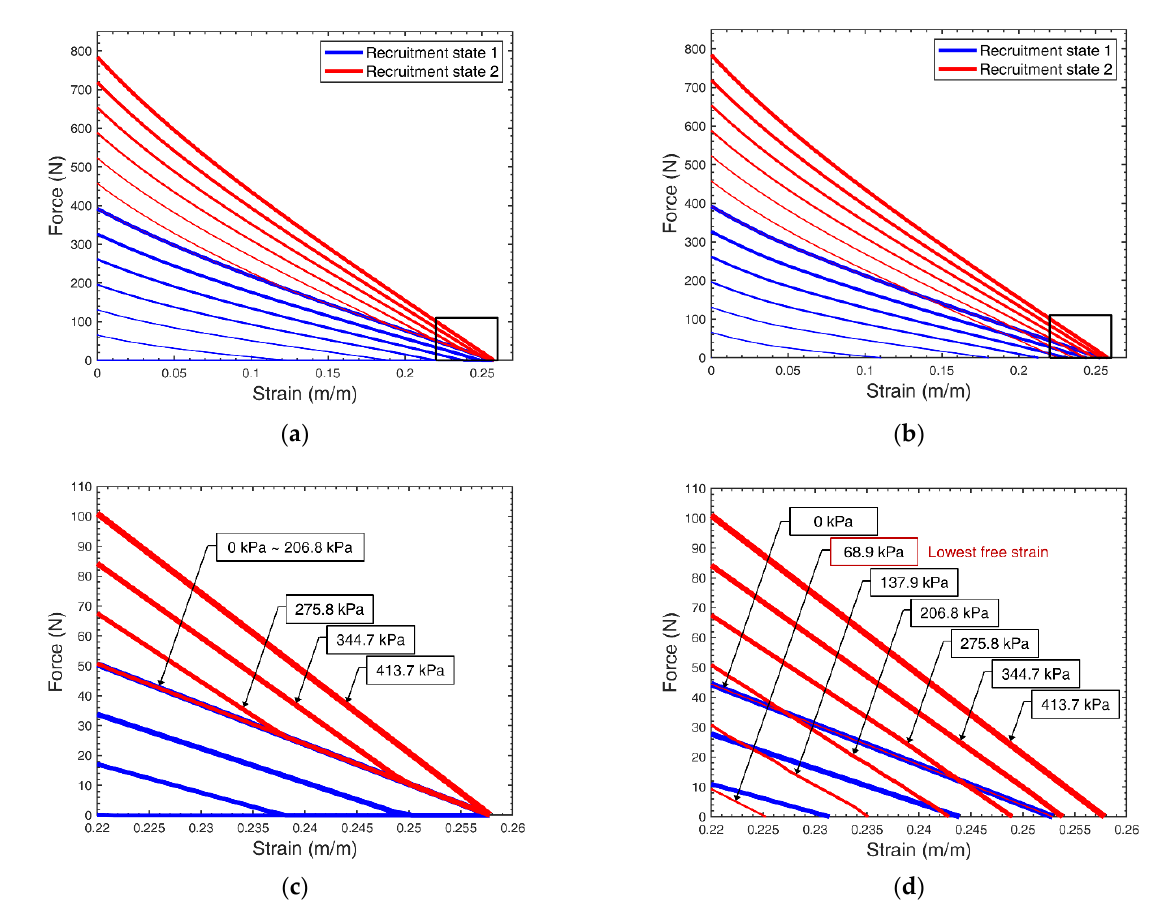
Figure 9. Force–strain space of a variable recruitment bundle with two motor units (MUs) of equivalent cross-sectional area with ( a ) resistive forces neglected, and ( b ) resistive forces considered. ( c , d ) show zoomed-in views of the force–strain space near maximum strain with resistive forces neglected and included, respectively. Increasing pressure values are represented by increasing thickness of lines. In recruitment state 2 (red lines), the pressure applied to MU 1 is constant at 413.7 kPa, while the pressure applied to MU 2 is indicated in ( c , d ) to show the progression from inactive to fully active.